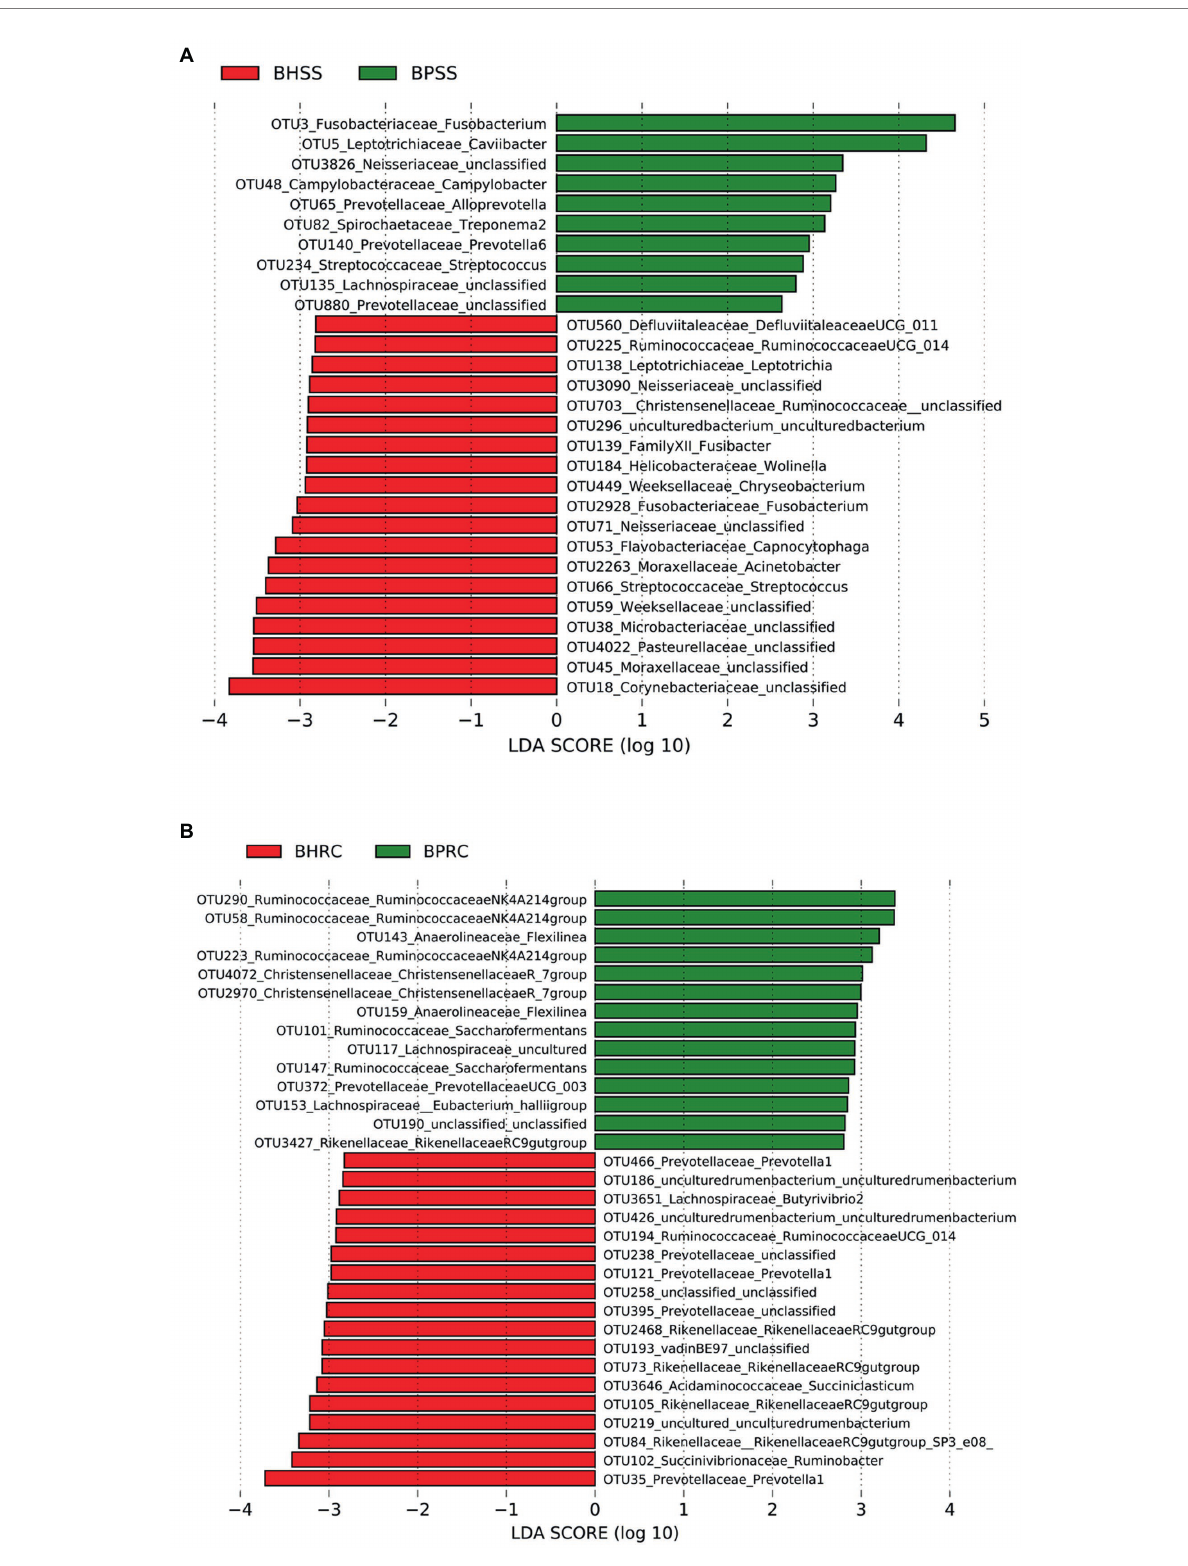
FIGURE 6 Statistically significant genera or higher taxa that differentiate microbiomes from healthy cattle and those with periodontitis. (A) Dental microbiome (BHSS—healthy animals; BPSS—bovines with periodontitis): only genera and taxa with linear discriminant analysis (LDA) score greater than 2 are shown. (B) Ruminal microbiome (BHRC—healthy animals; BPRC—bovines with periodontitis): only genera and taxa with an LDA score greater than 2.8 are